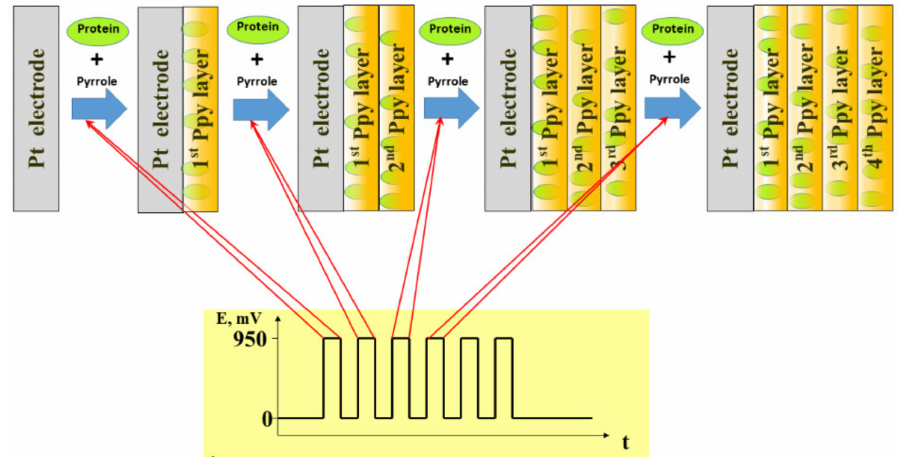
Figure 2. Electrochemical deposition of conducting polymer–polypyrrole and entrapment of proteins within formed Ppy layer, while potential pulses are applied. Adapted from